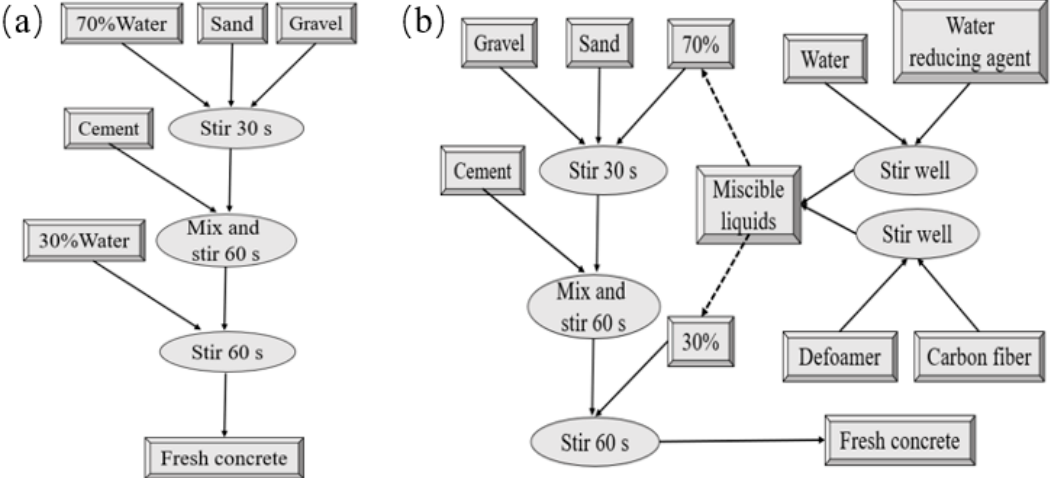
Figure 1. Preparation process of carbon fiber reinforced concrete. ( a ) PC group of specimens; ( b ) CNFCR1, CNFCR2, CNFCR3 and CNFCR5 groups of specimens.